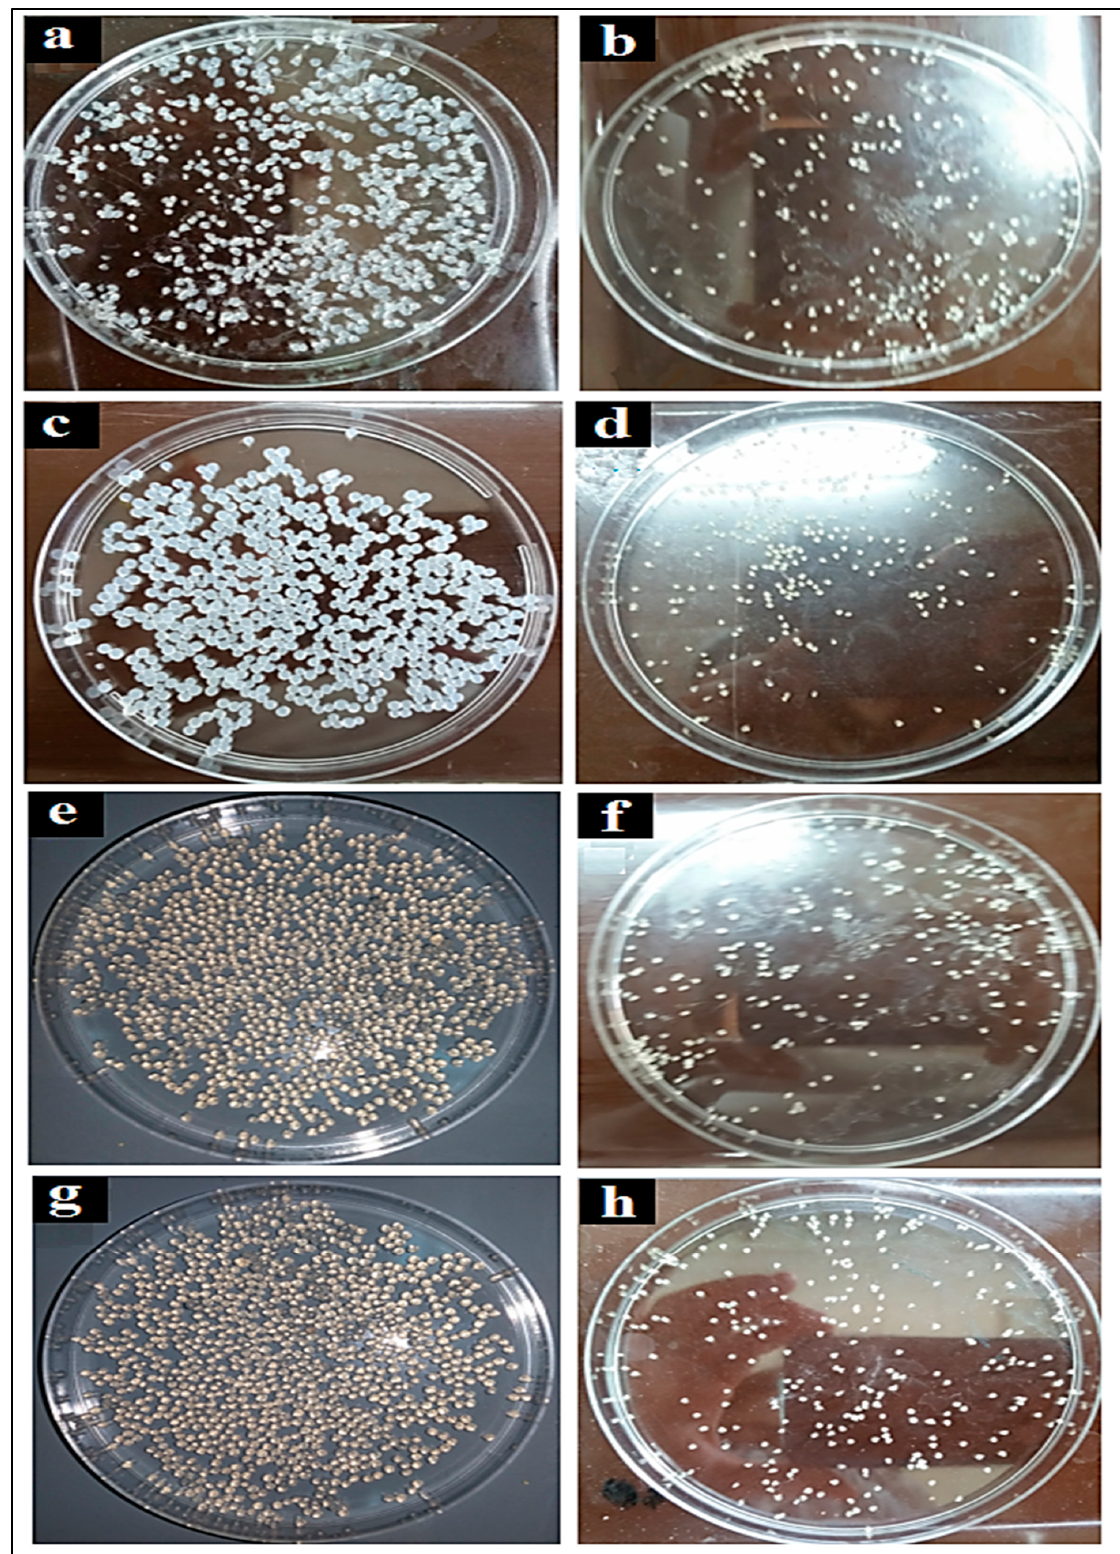
Figure 4. Shapes and appearance of the wet ( left ) and dry ( right ) microspheres: ( a , b ) at 0.5% ( w / v ), ( c , d ) at 0.75% ( w / v ), ( e , f ) at 1% ( w / v ), ( g , h ) at 1.25% ( w / v ).